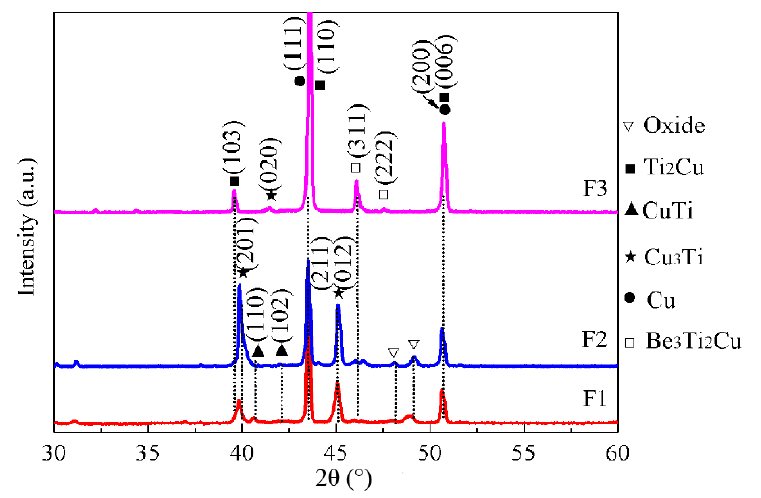
Figure 5. XRD results of the Cu-Ti films after plasma nitriding at 650 °C for 4 h.